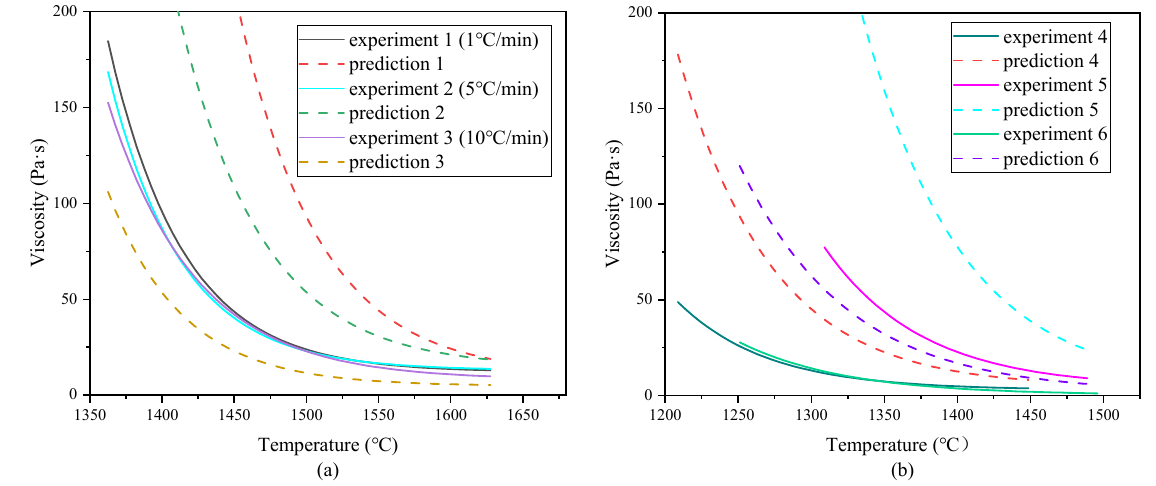
Figure 10. Indirect prediction results for slag viscosity: ( a ) the same sample at different cooling rates; ( b ) different samples.